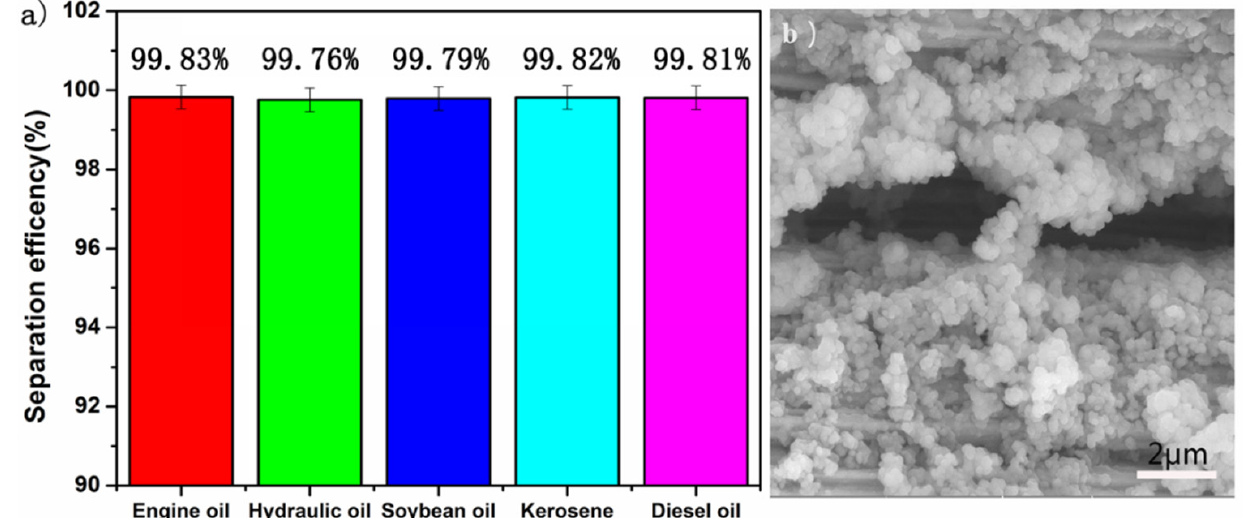
Figure 7. ( a ) The separation efficiency of SiO 2 -Na 2 SiO 3 -coated SSF after being immersed in hot water for 2 weeks and ( b ) corresponding SEM image.